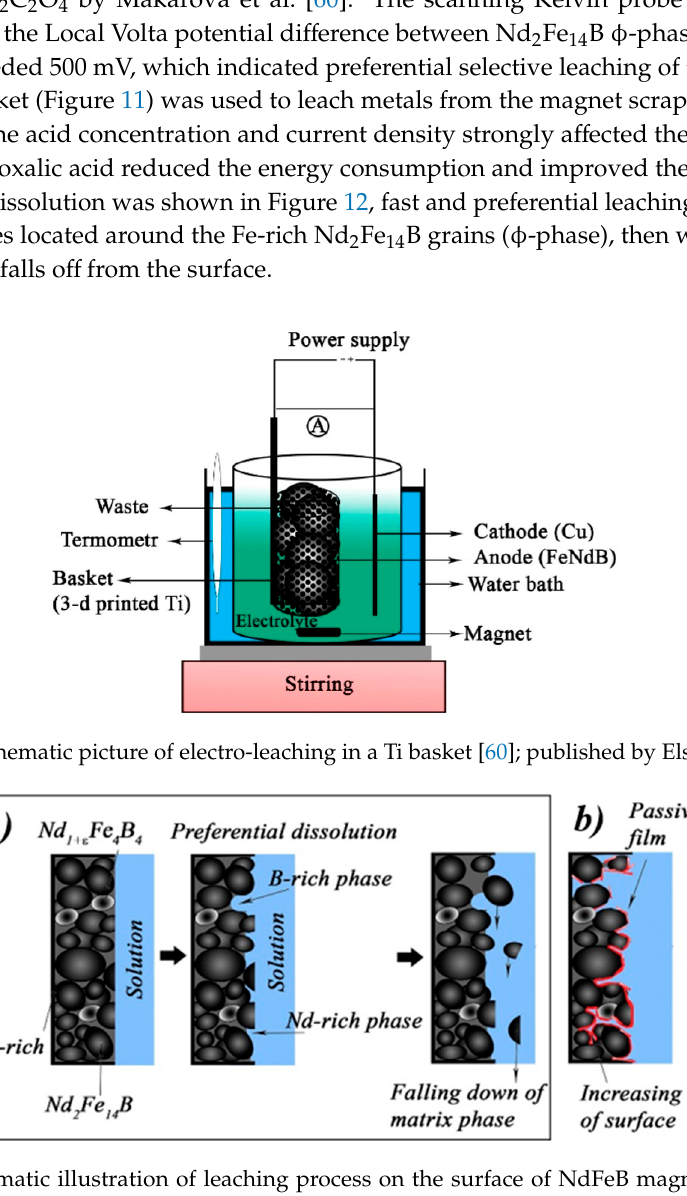
Table 3. Comparison of different REEs separation technologies for NdFeB permanent magnet scraps. Methods.